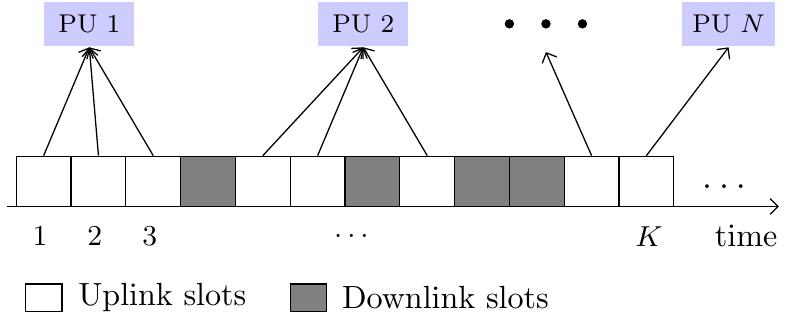
Figure 4. Channel view of the system